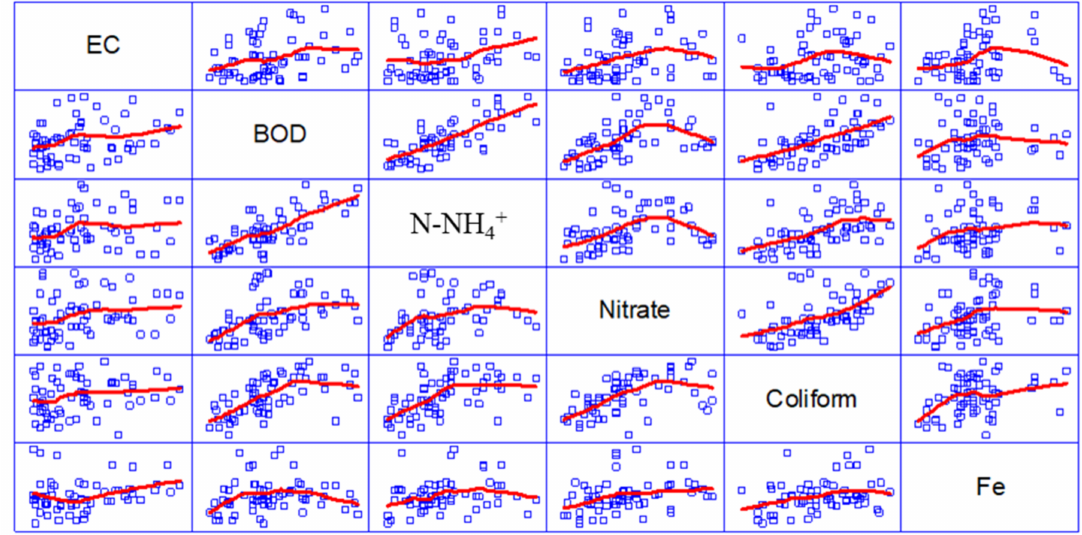
Figure 6. Correlation among the most water pollutants.